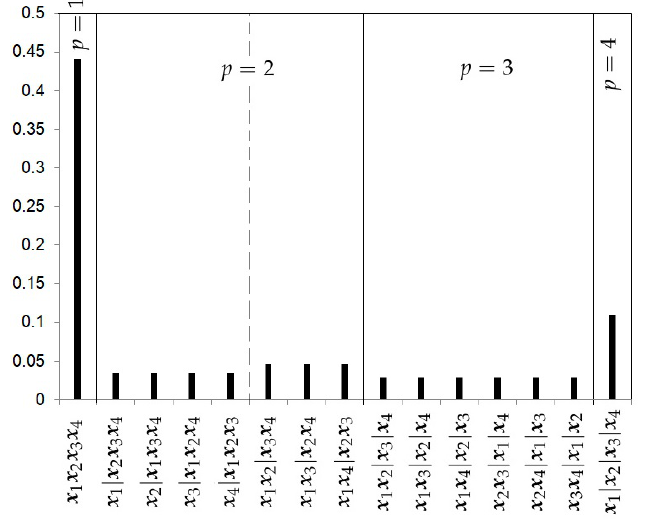
Figure 5. Hierarchical Poisson prior with 3 levels probabilities for the partitions with k = 4